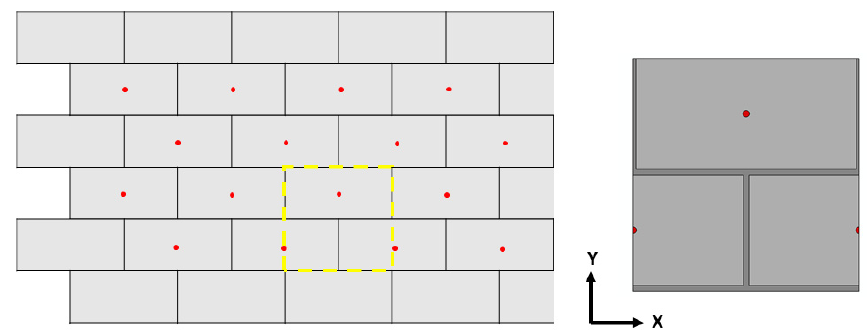
Figure 2. Unit cell of brick wall with metal fasteners.